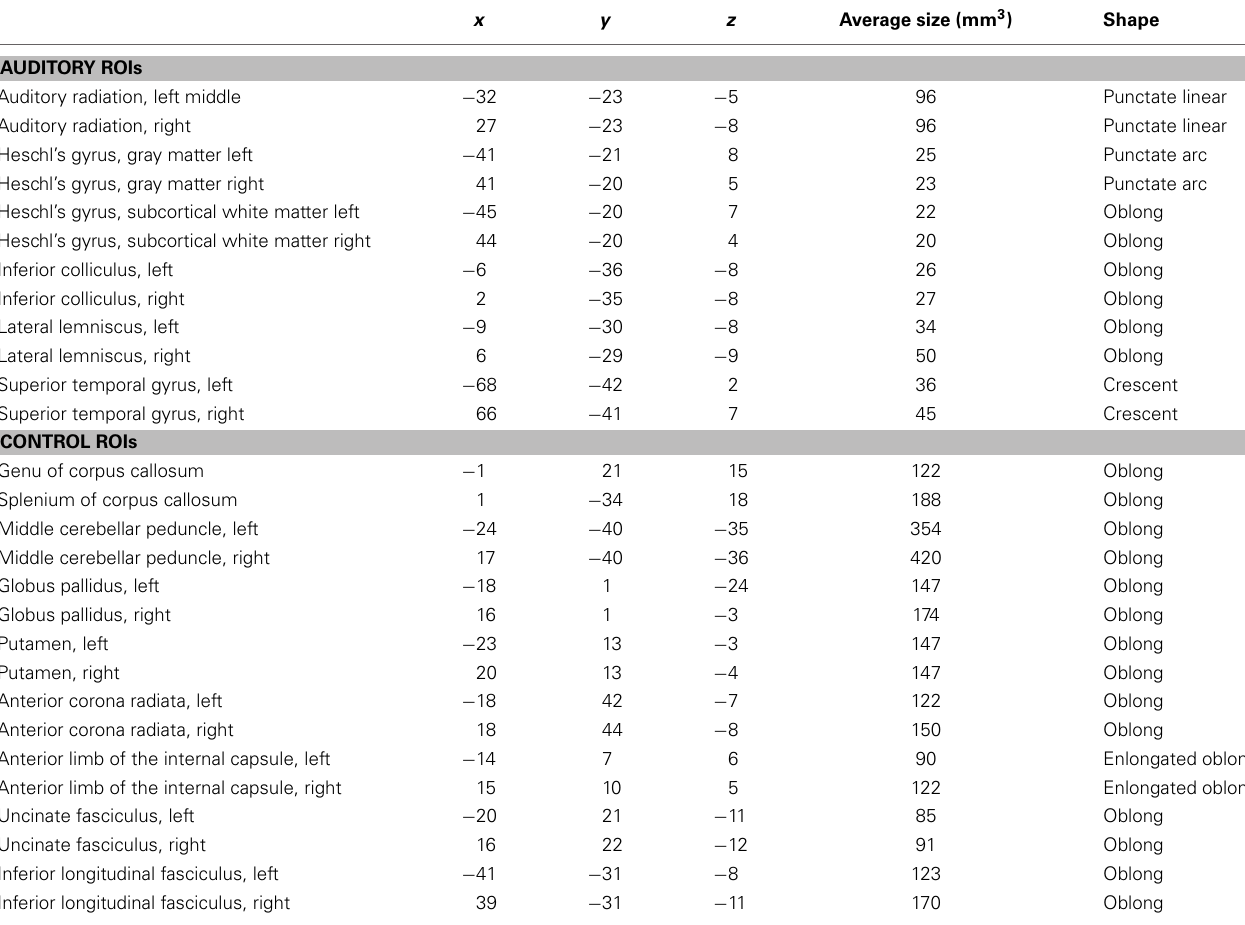
Table 1 | MNI coordinates for regions of interest (ROI) used in the